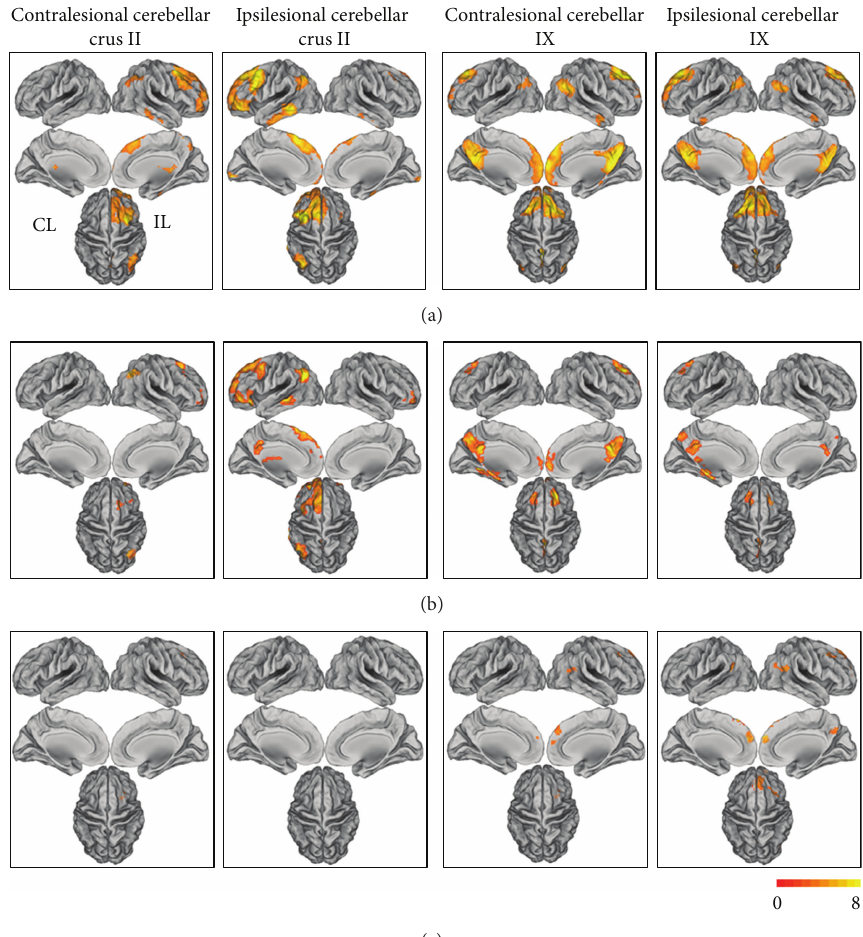
Figure 4: The rsFC patterns of the cerebellar subregions in healthy controls and stroke patients (subgroup: 𝑛 = 11 ) and the rsFC differences between stroke patients and healthy controls ( 𝑃 < 0.05 corrected). (a) The rsFC patterns of the cerebellar subregions in healthy controls; (b) the rsFC patterns of the cerebellar subregions in stroke patients; (c) the differences in the rsFCs between stroke patients and healthy